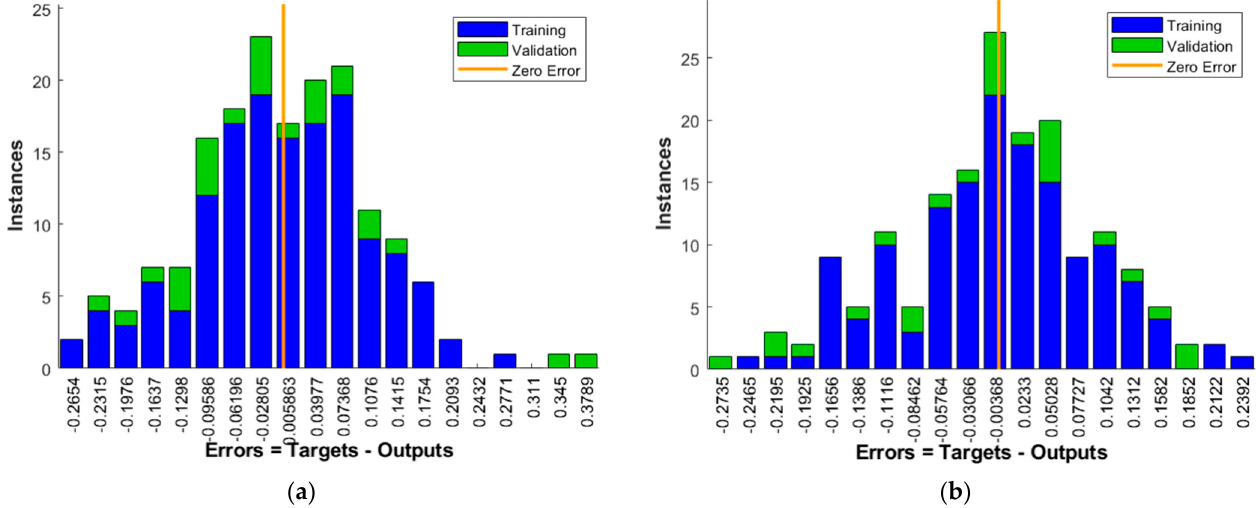
Figure 4. Error histogram for: ( a ) Initial model; ( b ) Optimized model.